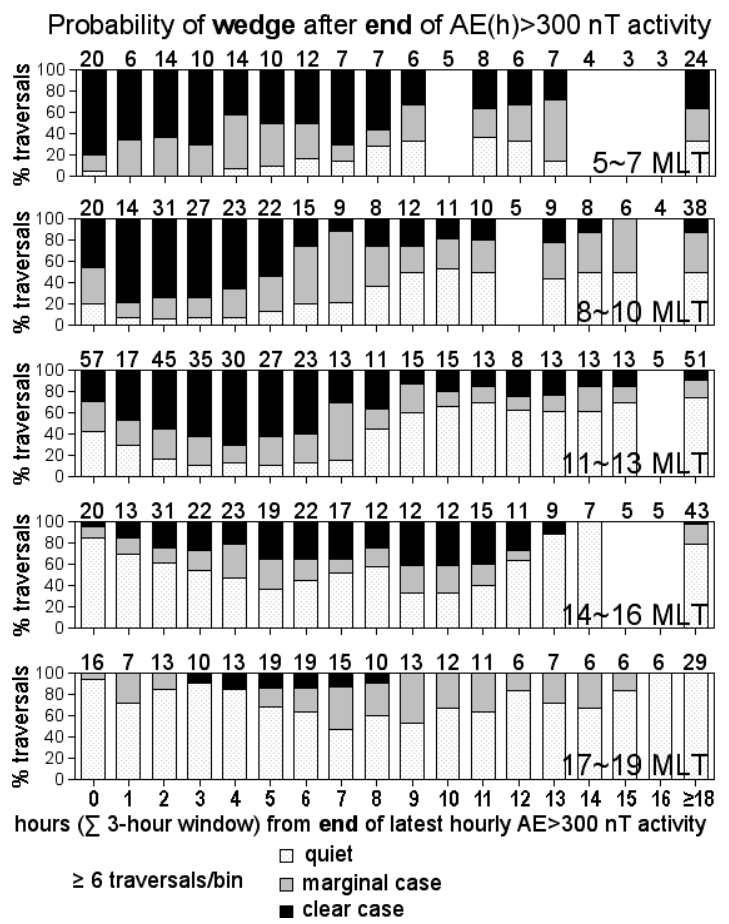
Fig. 5. Probabilities of observing a wedge-like structure for different time-lags from the end of the high AE period (hourly AE> 300nT). From top to bottom, 05 ∼ 07 MLT, 08 ∼ 10 MLT, 11 ∼ 13 MLT, 14 ∼ 16 MLT, and 17 ∼ 19 MLT. In each panel, the black bar, gray bar, and white bar denote the traversals with clear signature of structured dense sub-keV ions, with some structure but not strong signature, and with very weak or no signature, respectively. To increase statistics, a 3-h window (running summation) is taken, and the horizontal axis shows the central time-lag from the end of activity. For example, the time-lag of 5h means that the actual time-lag is 4, 5, or 6h, i.e. the hourly AE has been less than 300nT for at least 4h before the traversal but it was more than 300nT at 5, 6, or 7h before the traversal. For the time-lag of 1h and 0h, we did not take such a running summation (window is 1h). The last column denotes all traversals that the time-lag is equal to or more than 18h. The bins with less than 6 traversals are not shown. The total number of traversals in each 3-h bin is written at the top of each